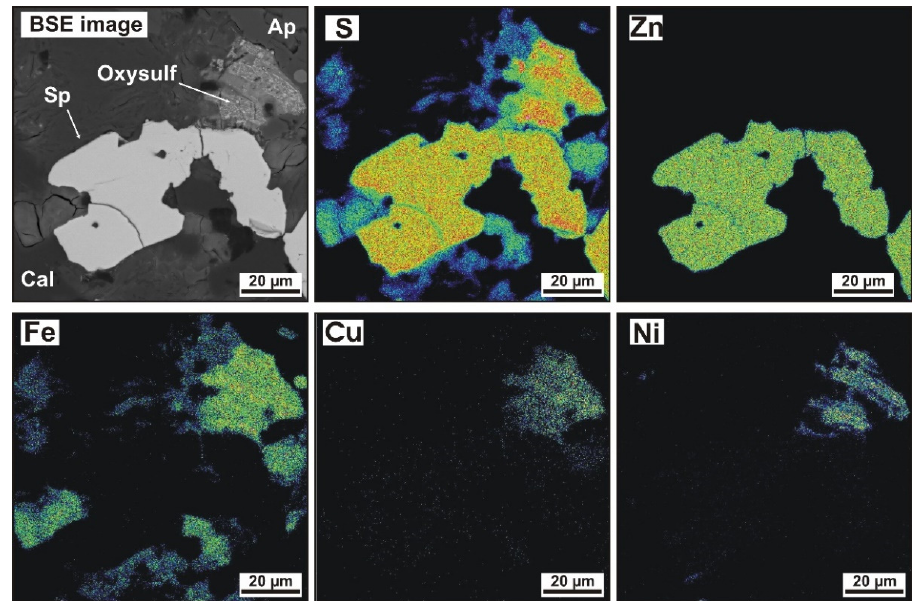
Figure 9. BSE image and elemental maps (S, Zn, Fe, Cu, Ni) showing the chemical homogeneity of sphalerite from sample DT-25. Ap = fluorapatite, Cal = calcite, Oxysulf = complex Ca-Fe-Cu-S-Se-O compounds (oxychalcogenides ?), Sp = sphalerite.